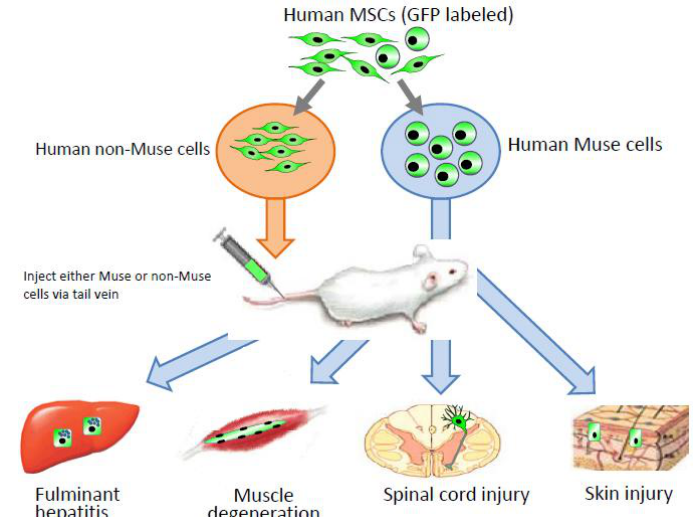
Figure 4. Contribution of Muse cells to tissue repair.